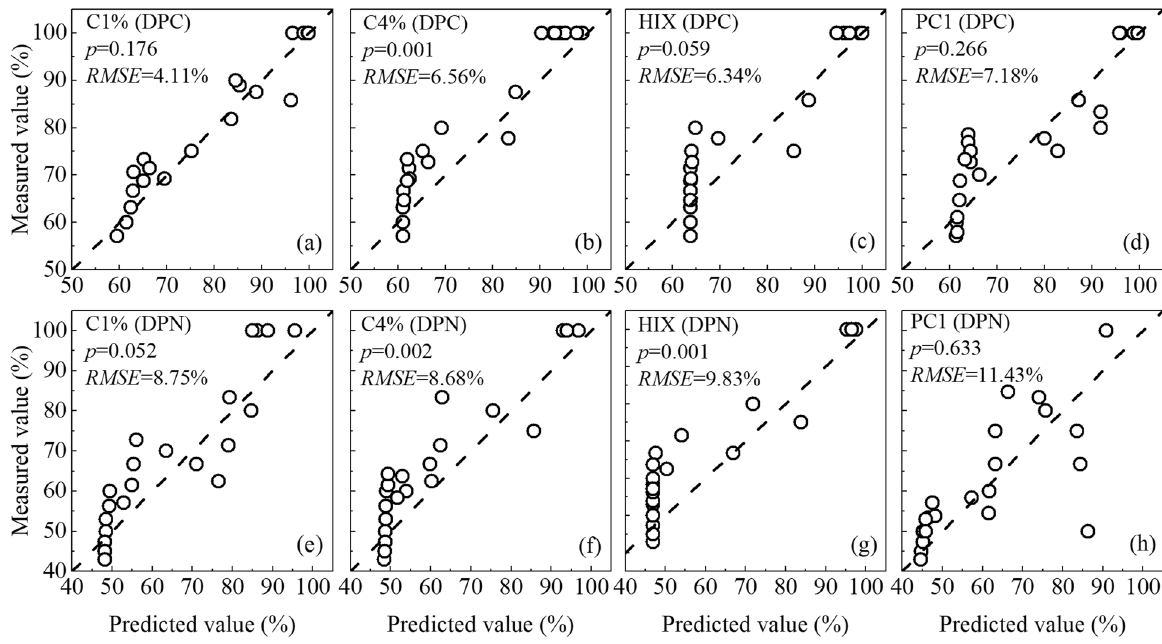
Fig. 5 Scatter plot of the predicted values and measured values of groundwater samples ( n = 21). The function of the dashed line is y = x . The p value was obtained by the paired t-test between the predicted values and the measured